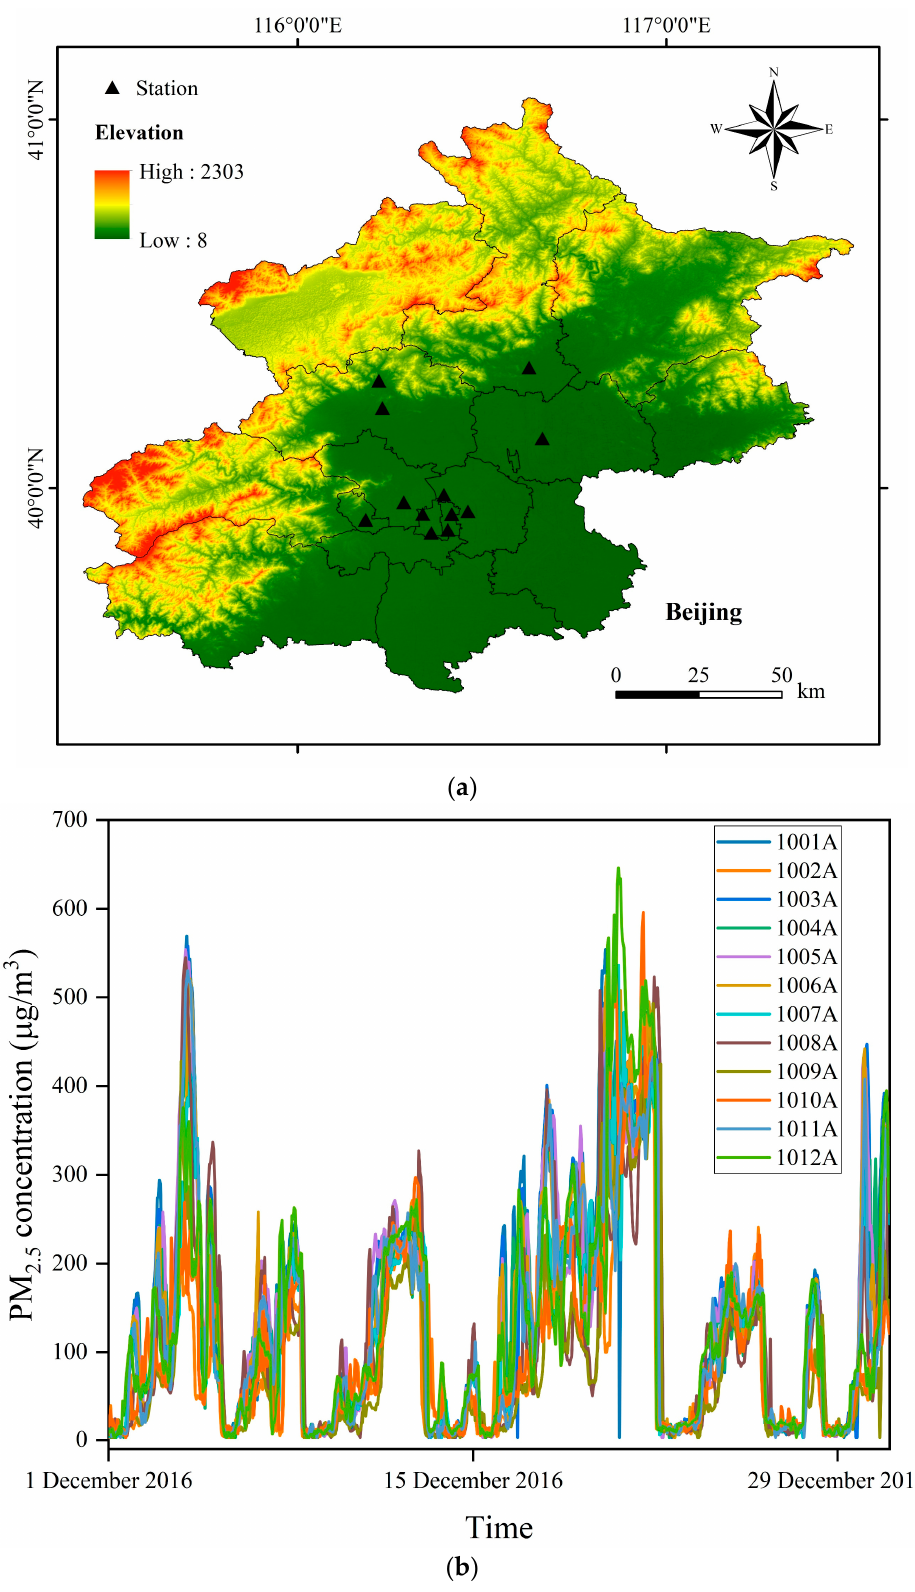
Figure 1. ( a ). Distribution of air quality monitoring stations in Beijing. ( b ). Time series plot of PM 2.5 concentration data.